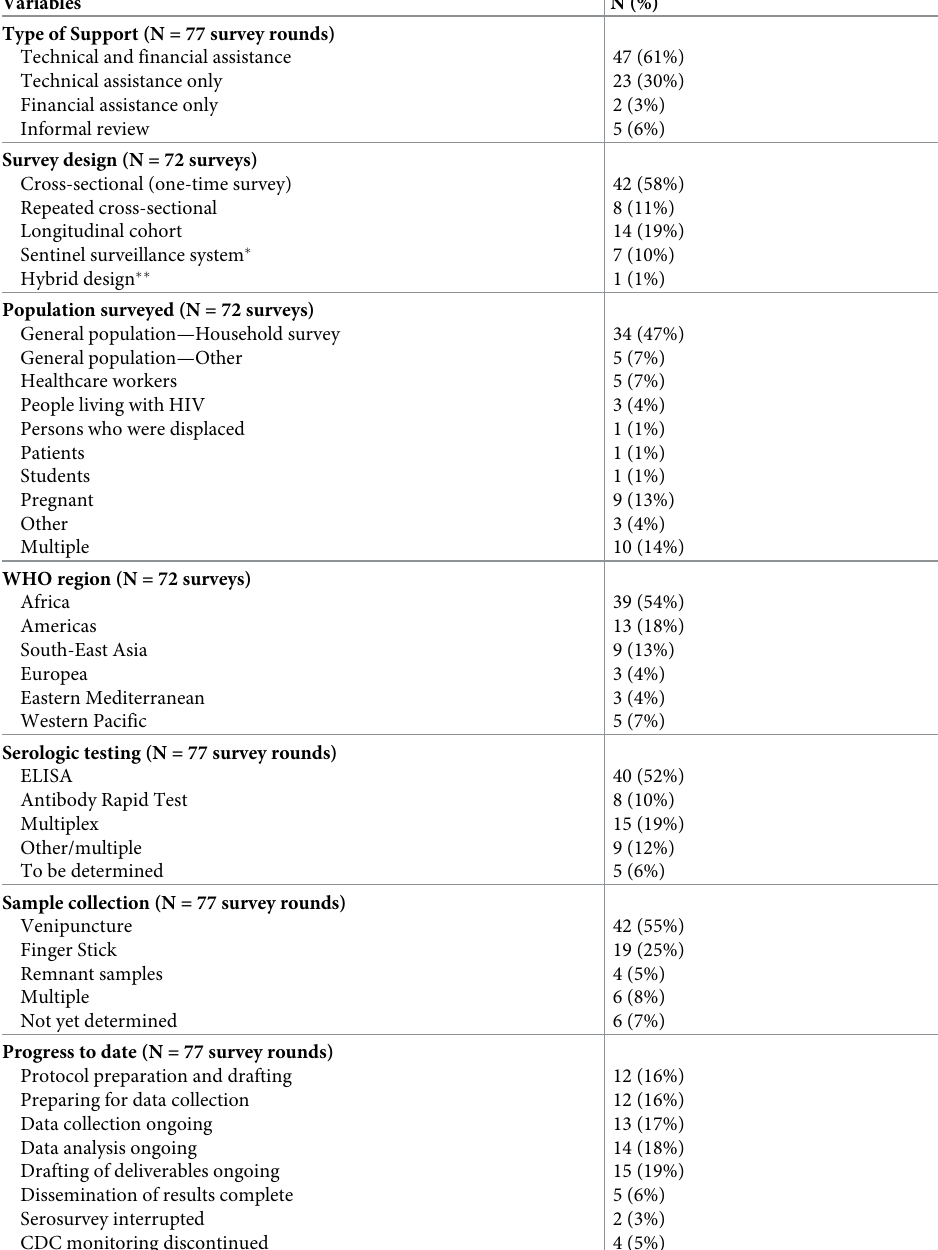
Table 1. Summary of CDC-supported international SARS-CoV-2 seroprevalence surveys (N = 72 surveys / 77 sur- vey